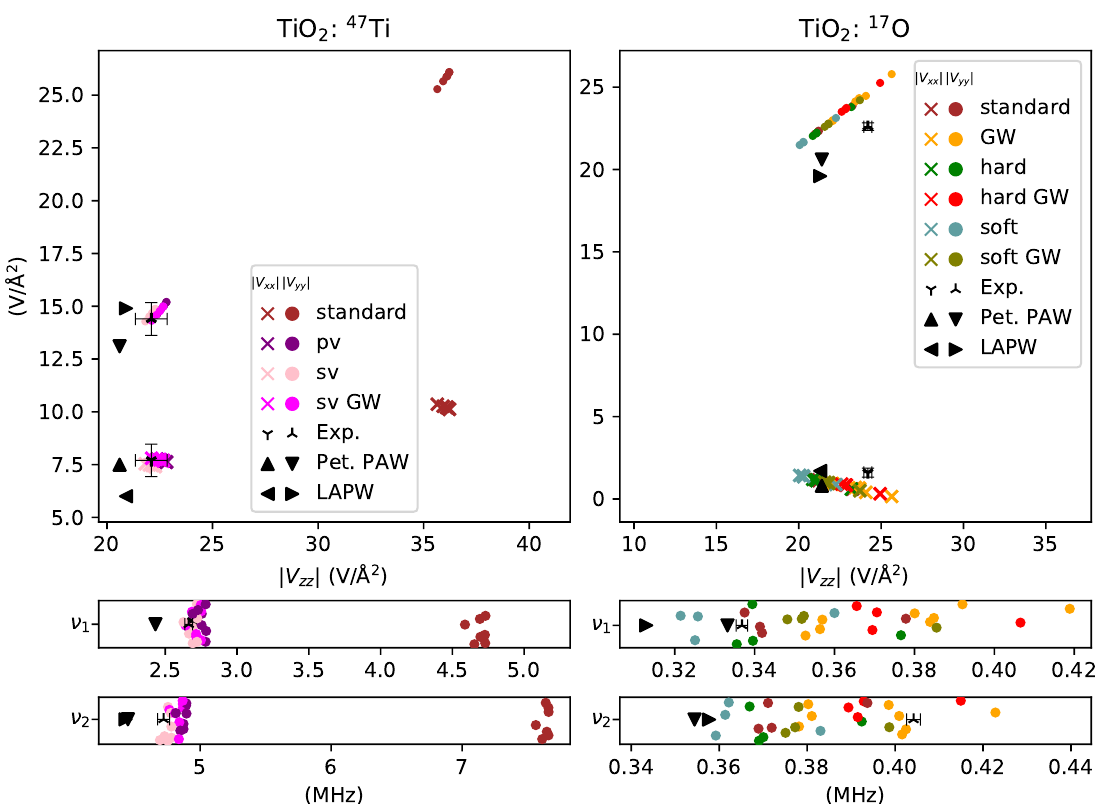
Figure 3. EFG plots for 47 Ti and 17 O in TiO 2 are shown at the top; the corresponding NQR frequencies are shown underneath. Colored markers show a computed value for each PAW potential. Literature data [16], shown in black, were calculated using both a PAW and LAPW method. Experimental data [45] is shown as a three-pointed star. The V xx and V yy values were computed to be positive and the V zz negative for the titanium site. Following experimental data, V zz is negative for the oxygen site, while the other components are positive. As was done by Petrilli et al. [16], the EFG tensor was chosen to match the experimental orientation, which meant that | V yy | > | V zz | > | V xx | for the calculated